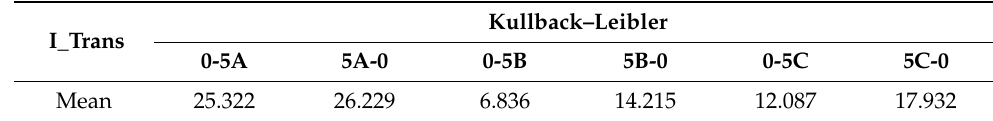
Figure 18. Comparison of the probability distributions obtained for the mean values of the transport motor current in the case of faults associated with the double sensors. Indicator: mean. Table 5. Kullback–Leibler divergence values associated with the mean values of the transport motor current for the identification of the faults associated with the double sensors.